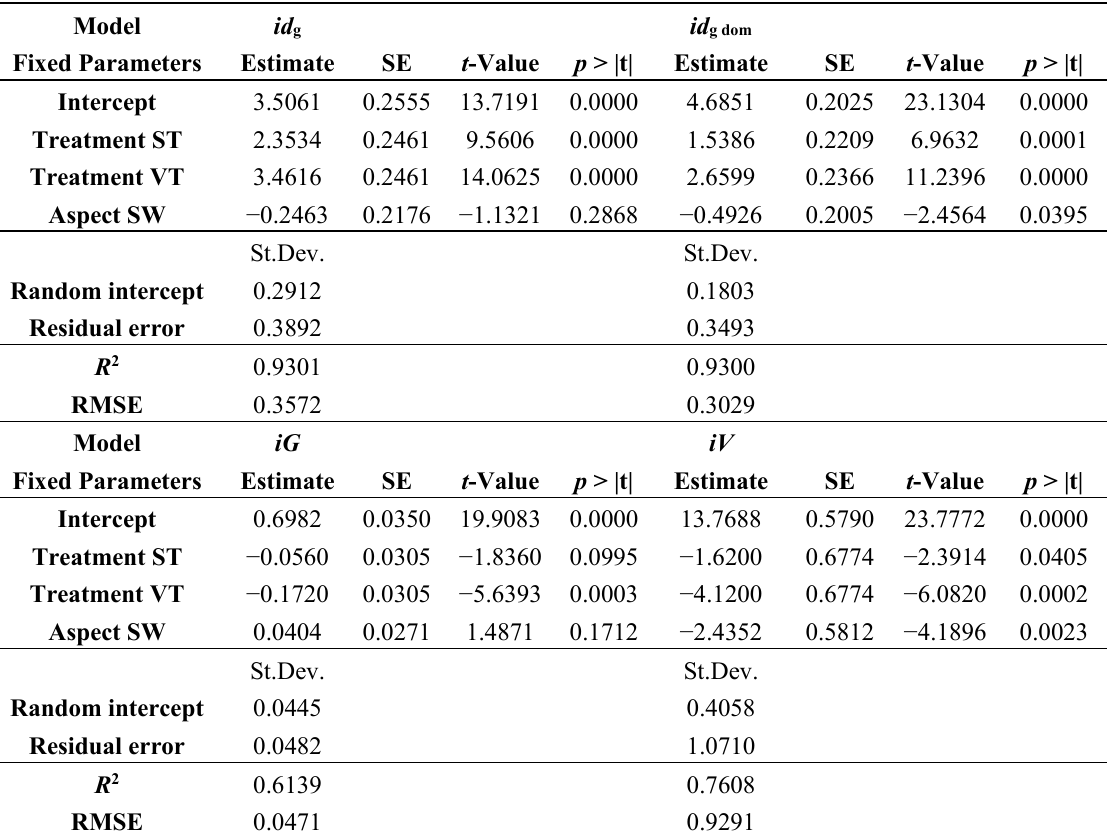
Table 4. Parameter estimates and error statistics for the stand level